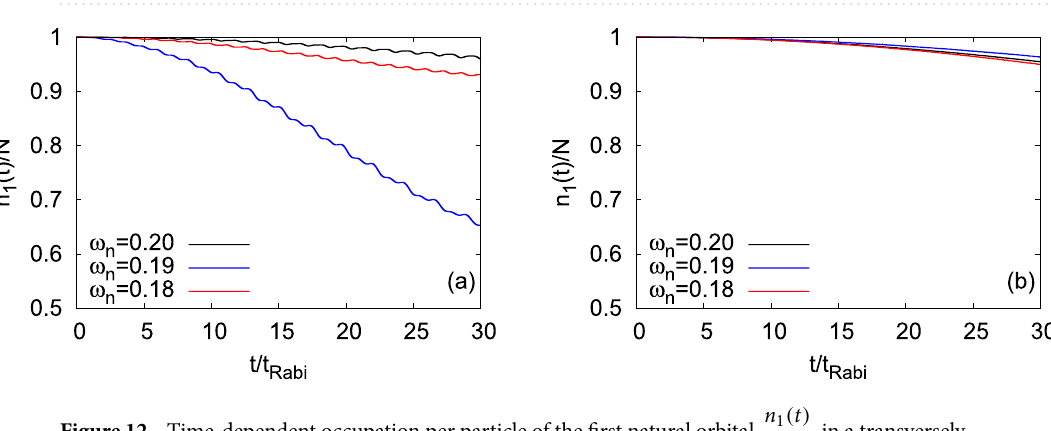
Figure 12. Time-dependent occupation per particle of the first natural orbital, asymmetric 2D double-well potential. The number of bosons is N 0.01 π . Panels ( a ) and ( b ) are for (cid:31) G and (cid:31) X , respectively. The data have been obtained with M � = time-dependent orbitals. We show here dimensionle ss quantities. Color codes are explained in each